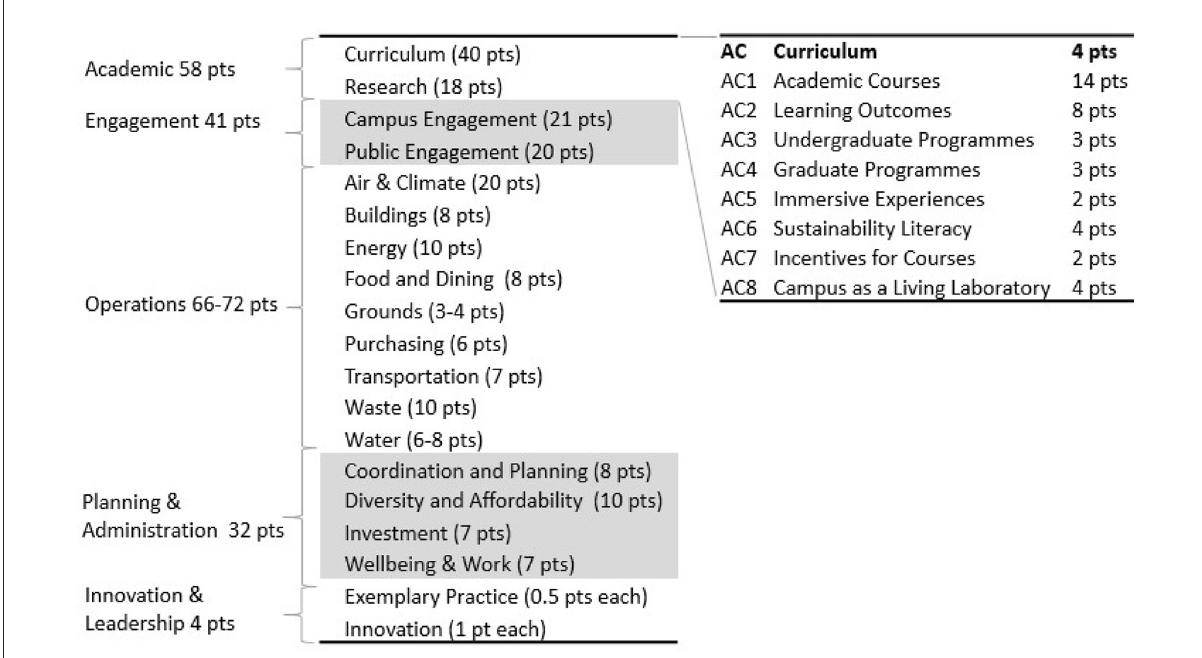
FIGURE1 STARS credit system [Source: (AASHE, 2015), pp. 3–5]. The maximum number of points (pts) available under each STARS category is